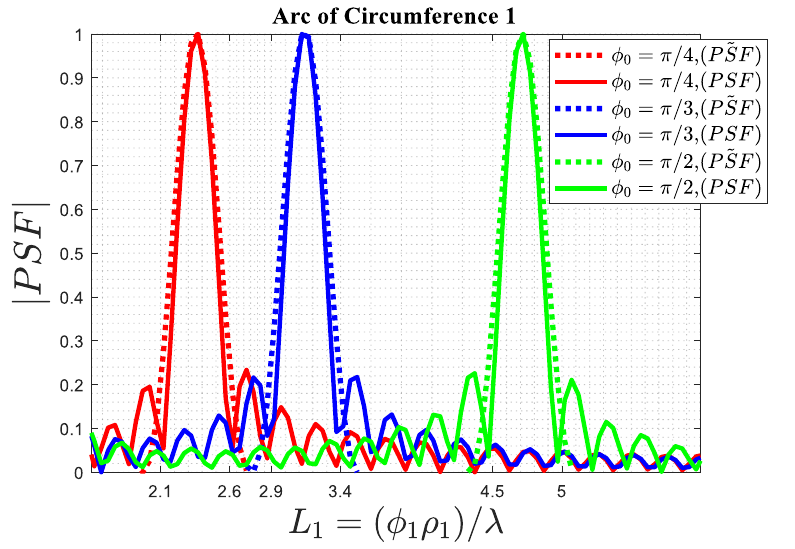
Figure 13. Comparison of the actual and approximated normalized PSFs for 𝜙 0 = 𝜋 4⁄ , 𝜋 3⁄ , 𝜋 2⁄ .